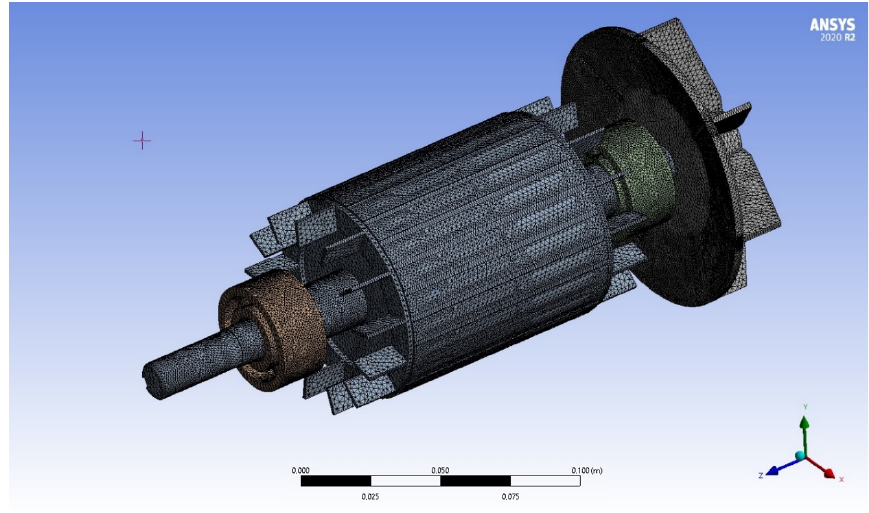
Figure 17. Creating a polygonal mesh of objects.